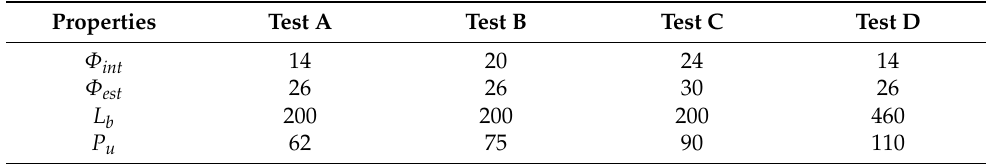
Table 6. Geometry (mm) and ultimate load (kN) of bonded anchorages [16]: (1) Φ int and Φ est = inter- nal and external diameters (mm); (2) L b = anchorage